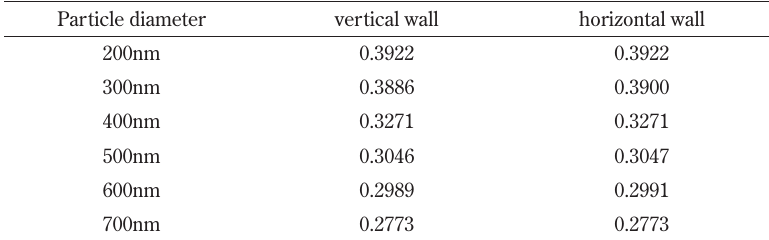
Table 2 Comparison of attachment efficiency in vertical and horizontal walls Particle diameter vertical wall horizontal